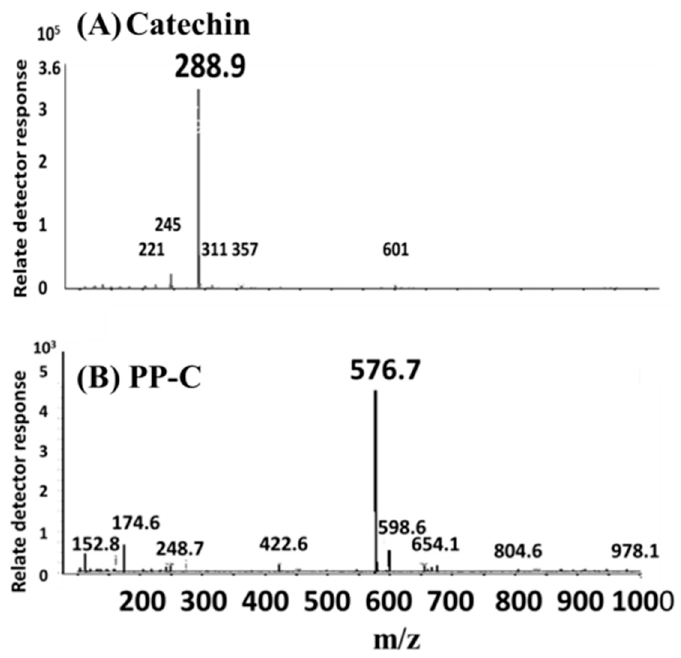
Figure 5. Electrospray ionization mass spectrum of ( A ) catechin at 17.63 min and ( B ) the photoreaction product from the catechin (PP-C) at 15.08 min.